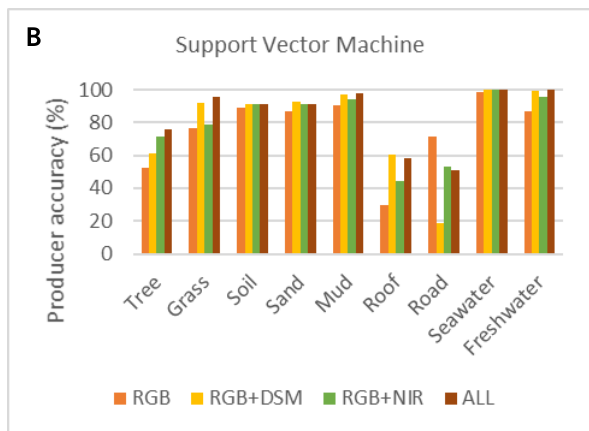
Figure 8. Barplot of the Pleiades-1 DSM and NIR contributions to the BGR classification performance (Producer’s Accuracy) built with the maximum Likelihood (ML) and Support Vector Machine (SVM) algorithms